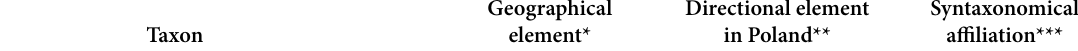
Tab. 1 Vascular plant species characterizing Pomerania – geographical and directional element and syntaxonomical